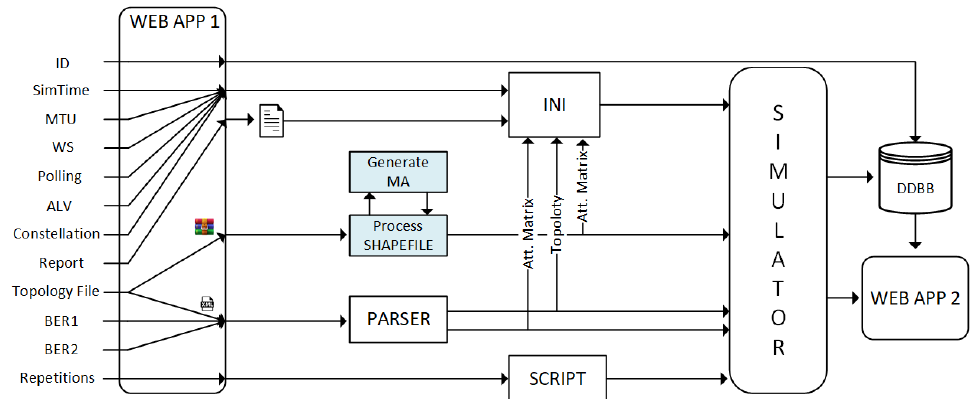
Figure 5. Low-level design of the web application developed for SimPRIME. WEB APP1 and WEB APP2 refer to different screens of the developed web app.